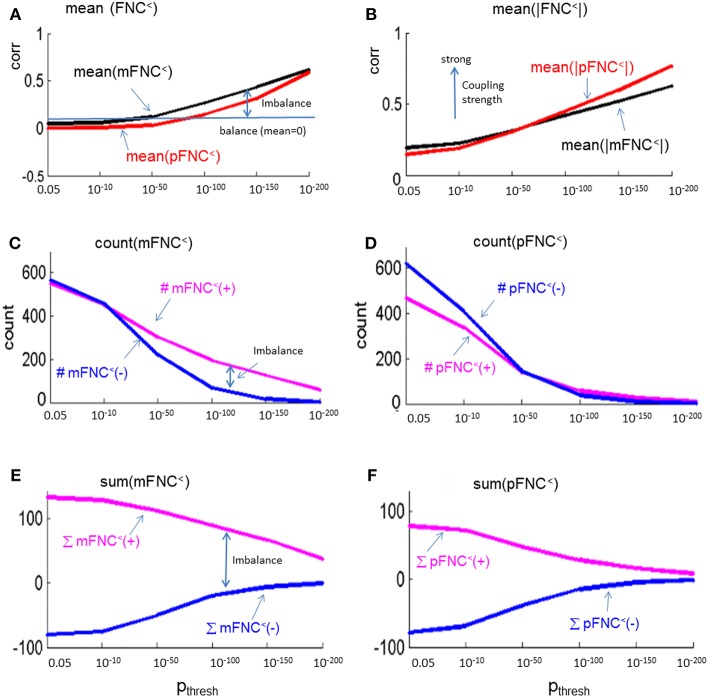
Numerical characteristics of mFNC and pFNC under p-value thresholding. (A)
mean(mFNC<) and mean(pFNC<) whole-brain network balance; (B)
mean(|mFNC<|) and mean(|pFNC<|) whole-brain network coupling strength; (C) Counts of positive and negative couplings in mFNC<; (D) Counts of positive and negative couplings in pFNC<; (E) Sums of positive and negative couplings in pFNC<; and (F) Sums of positive and negative couplings in pFNC<.